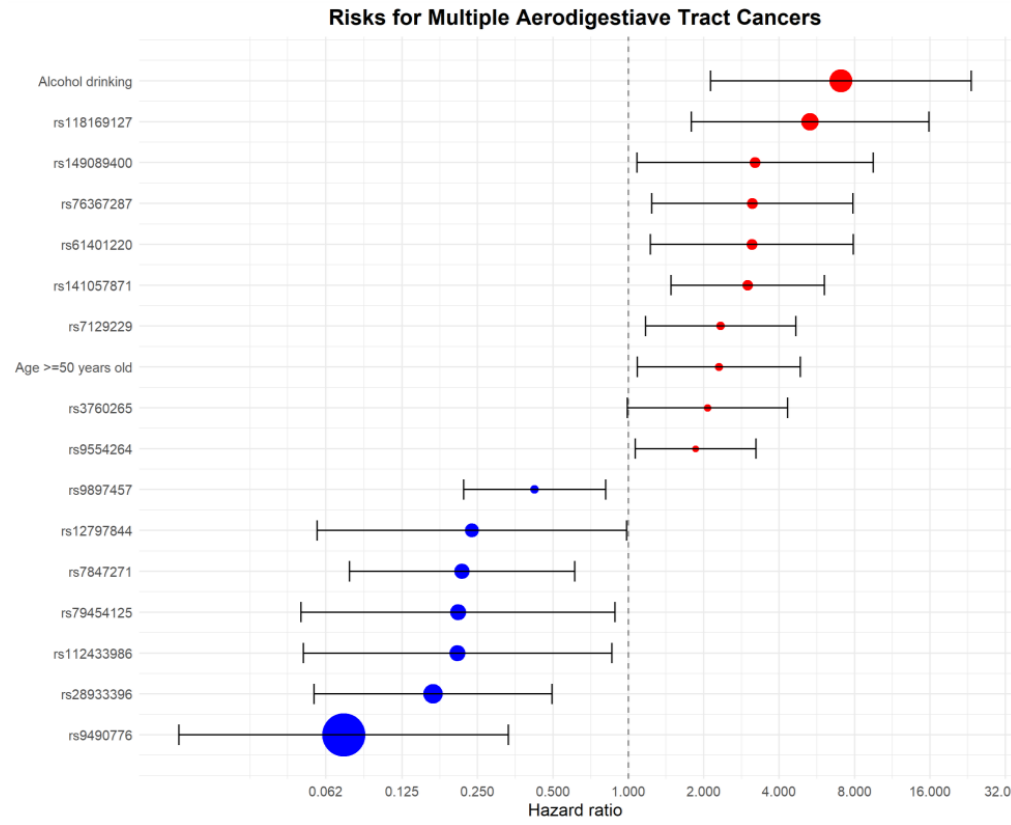
Figure 1. Hazard ratio to develop multiple aerodigestive tract cancer in oral cancer patients. (Red: increased risk; blue dot: decrease risk). The hazard ratio is represented by the size of the dot.